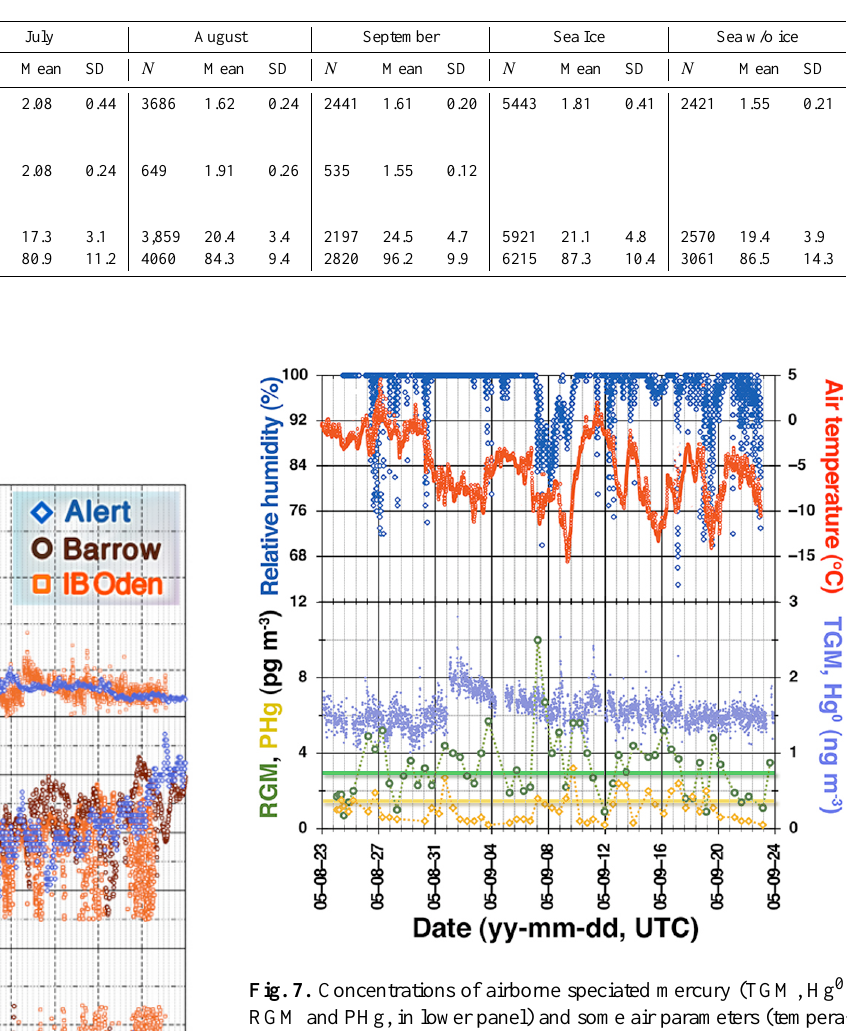
Table 3. Summary of screened TGM, Hg 0 ; O 3 and CO data applicable to the Arctic Ocean (incl. Baffin Bay, Northwest Passages, Beaufort Sea, Chukchi Sea, and Greenland Sea). Excluded are thus data from the North Atlantic Ocean, Labrador Sea and Bering Sea (IHO, 1953). Descriptive statistics of TGM data from station Alert on Ellesmere Island are included as well.